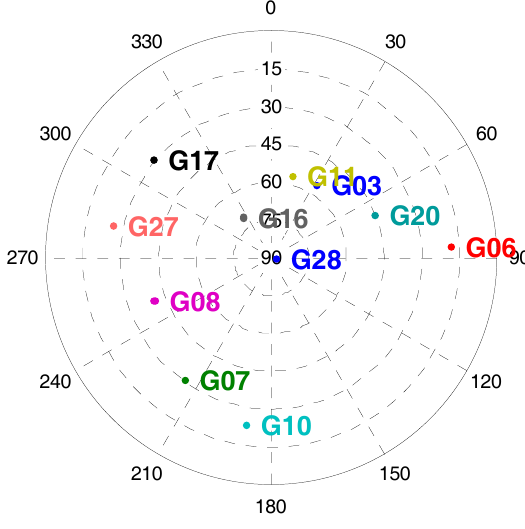
Figure 9. Satellite sky distribution in signal simulator tests.